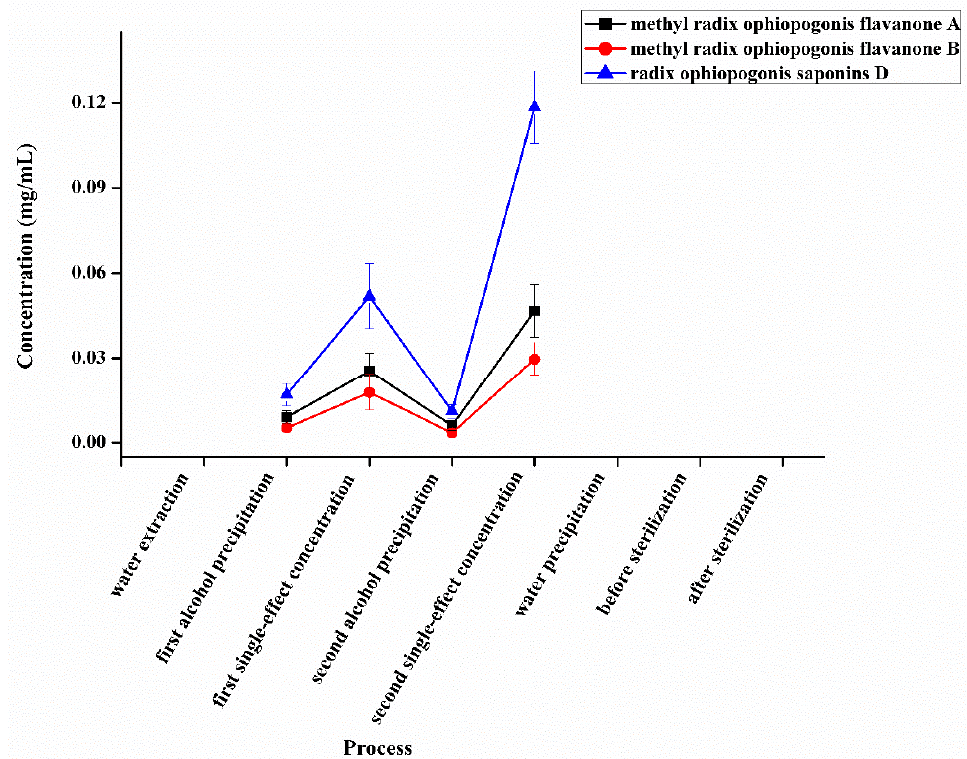
Figure 9. The transfer process of methyl radix ophiopogonis flavanone A, methyl radix ophiopogonis flavanone B, and radix ophiopogonis saponins D in O. japonicus.